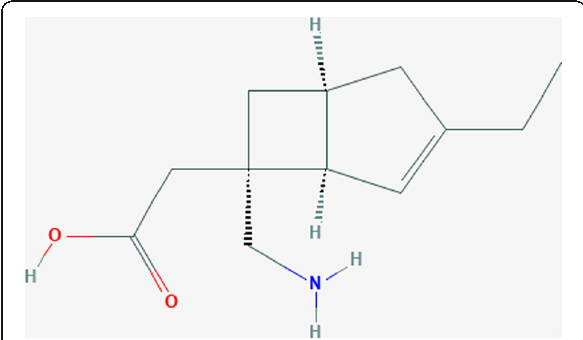
Fig. 1 Chemical structure of mirogabalin (figure source: PubChem [Internet]. Bethesda (MD): National Library of Medicine (US), National Center for Biotechnology Information; 2004-. PubChem Compound Summary for CID 59509752, Mirogabalin; [cited 2021 Jan. 11]. Available from: